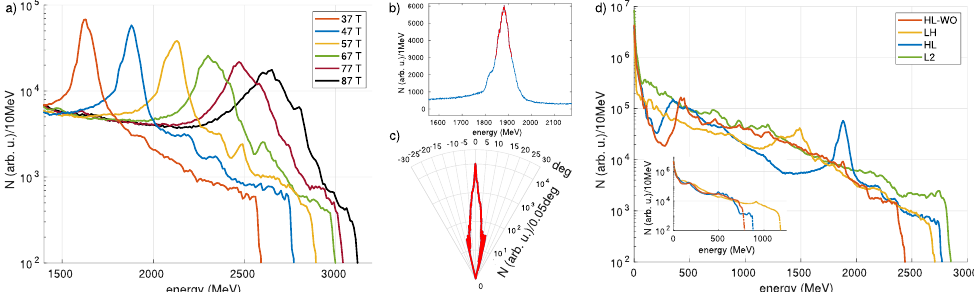
Figure 6. Properties of the ion beam. ( a ) Time evolution of the tail of the proton energy spectra in the HL case, ( b ) proton energy spectra of the HL case at time t = 47 T, with highlighted FWHM section used for ( c ) angular distribution, ( d ) proton energy spectra (corresponding deuteron energy spectra in inset) for various targets (see details in the text) at time t = 47 T. Reprinted from [41], with permission from